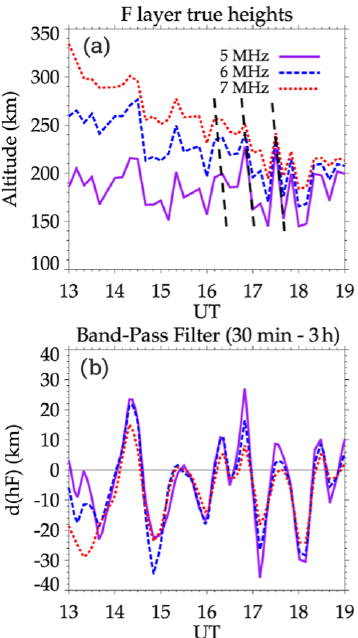
Figure 11. Temporal variations in the fixed-frequency (5, 6, and 7MHz) true heights, h F (a) , and deviation of h F (band-pass filtered (30min–3h)) (b) in CXP on 14 December